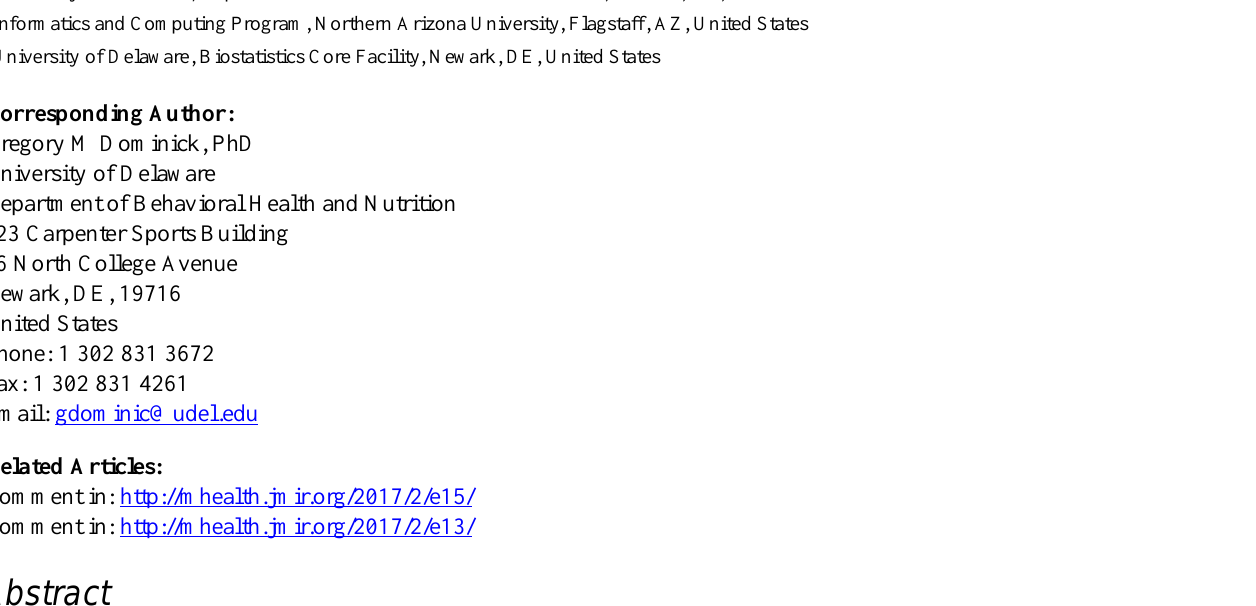
adults in free-living conditions.